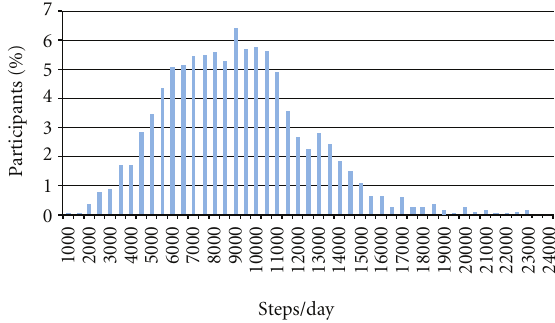
Figure 1: Histogram of steps taken per day. N =